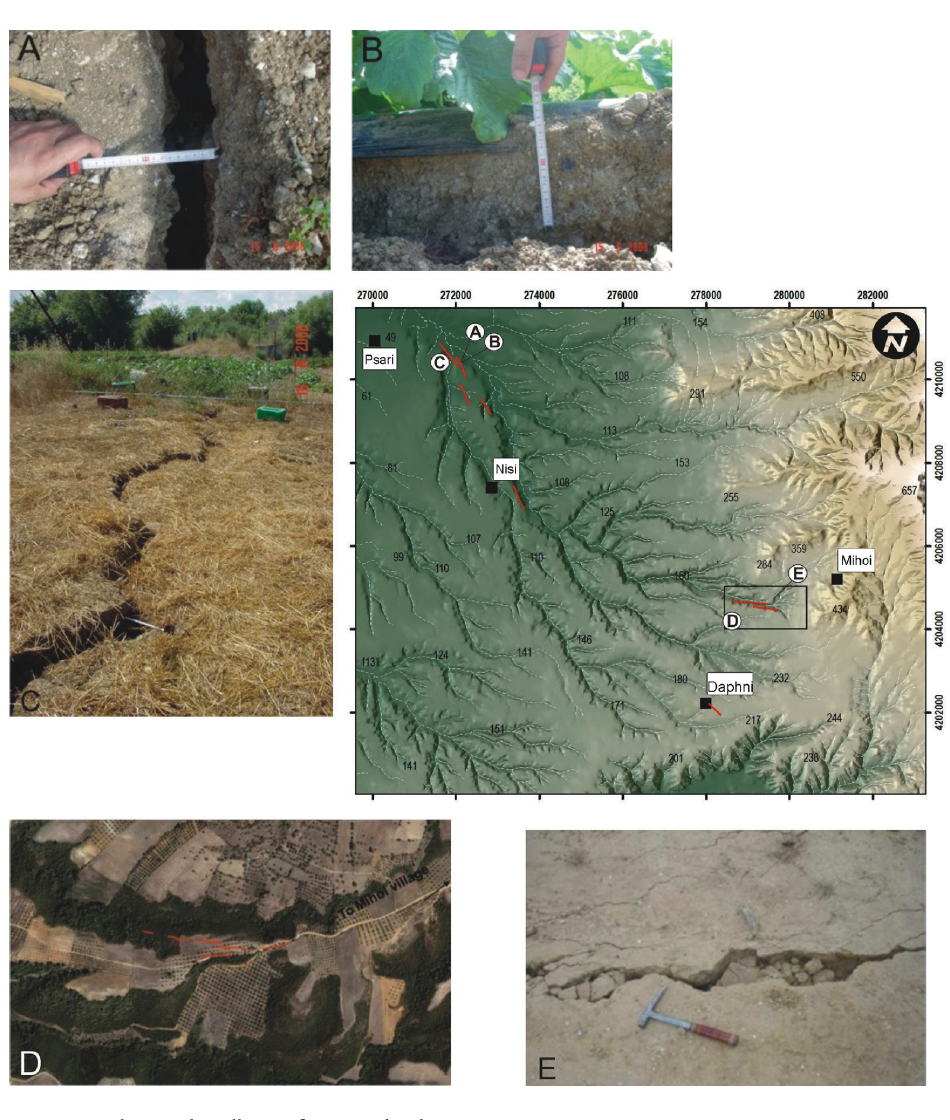
Figure 4. Surface ruptures close to the villages of Psari and Mihoi.